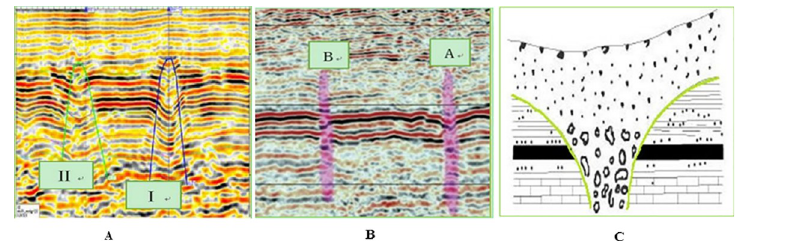
Fig 1. Three typical morphologies of collapse columns. (A) Inverted funnel shaped collapse column [25] . (B) Cylindrical shaped collapse column [26] . (C) Funnel shaped collapse column [27]